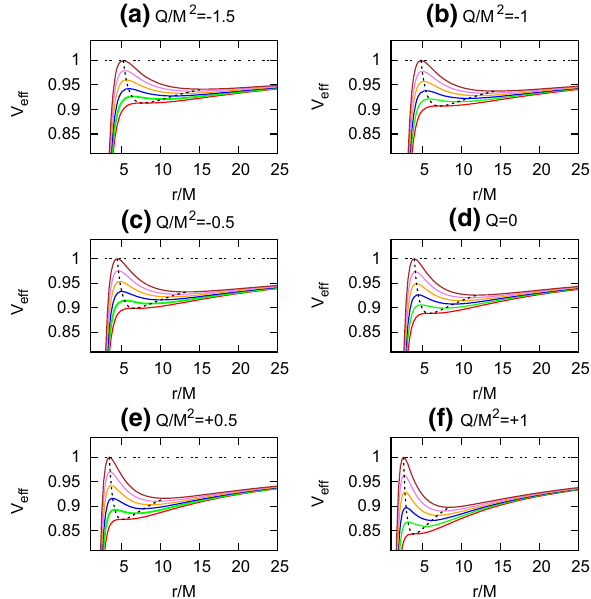
Fig. 4 The effective potential V eff as a function of r / M with a fixed Q . The angular momentum varies from l ISCO to l MBO from bottom to top. The dashed line represents the extremal points of the effective potential